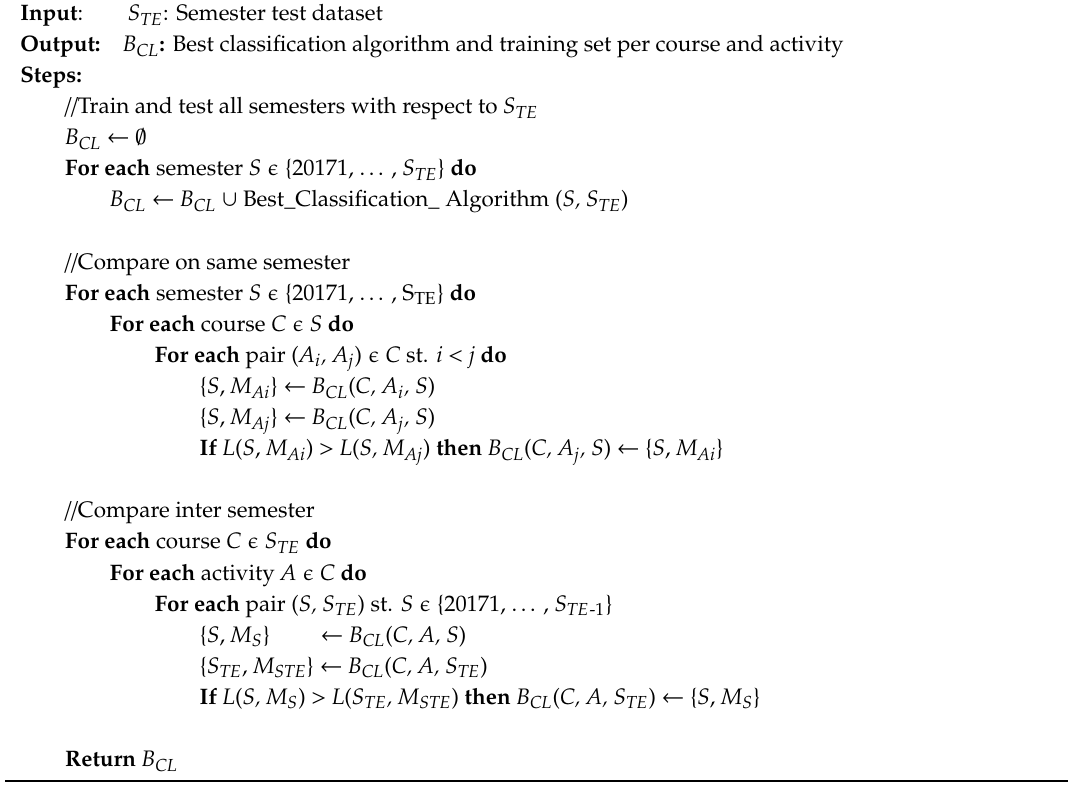
Algorithm 2. Pseudocode of Best_Classification_and_Training_Set.